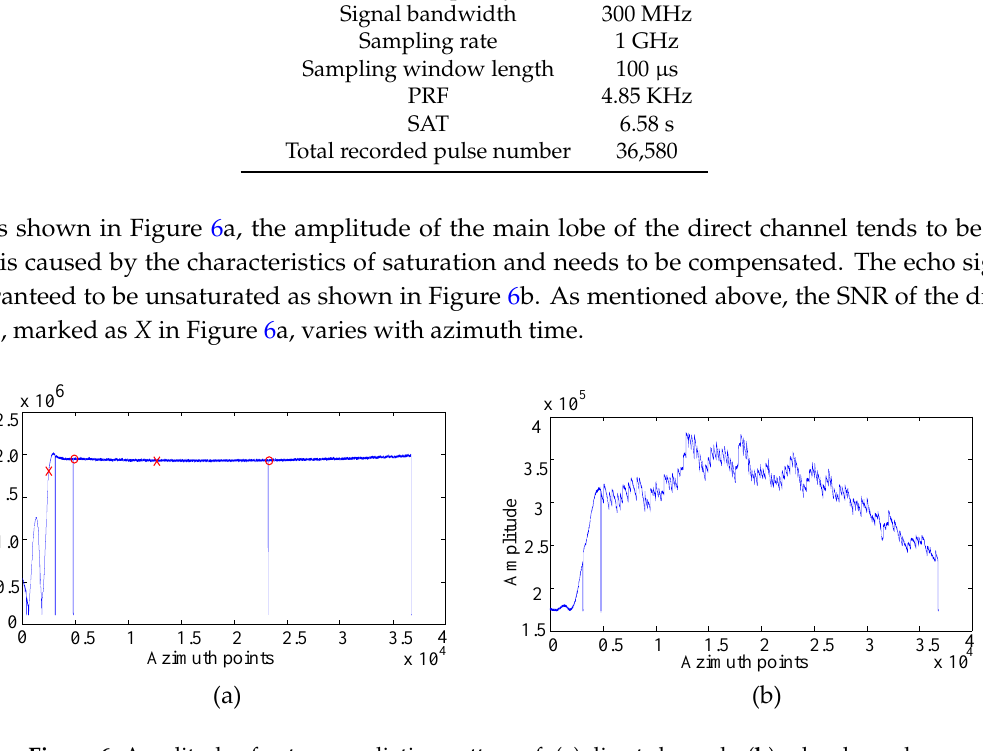
Figure 6. Amplitude of antenna radiation pattern of: ( a ) direct channels; ( b ) echo